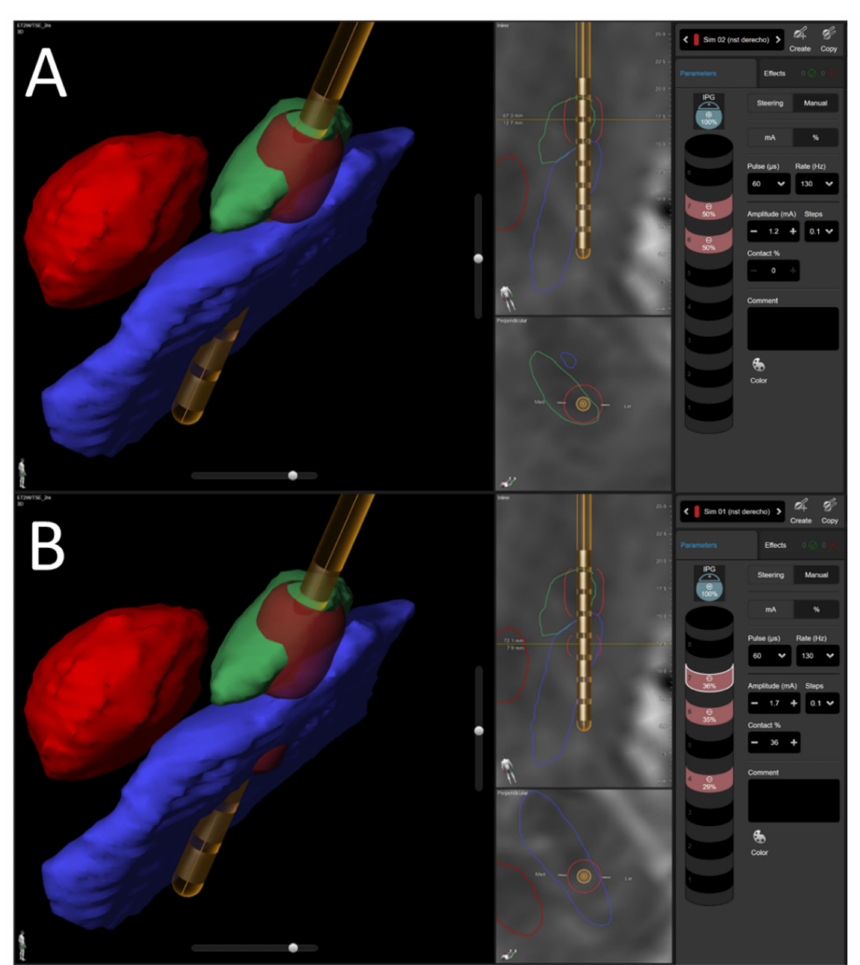
Figure 2. Stimulation Field Model of the STN ( A ) and STN+SNr ( B ). Green = STN; Blue = SNr; Ferrari Red = Red Nucleus; Dusty Red = Volume Tissue